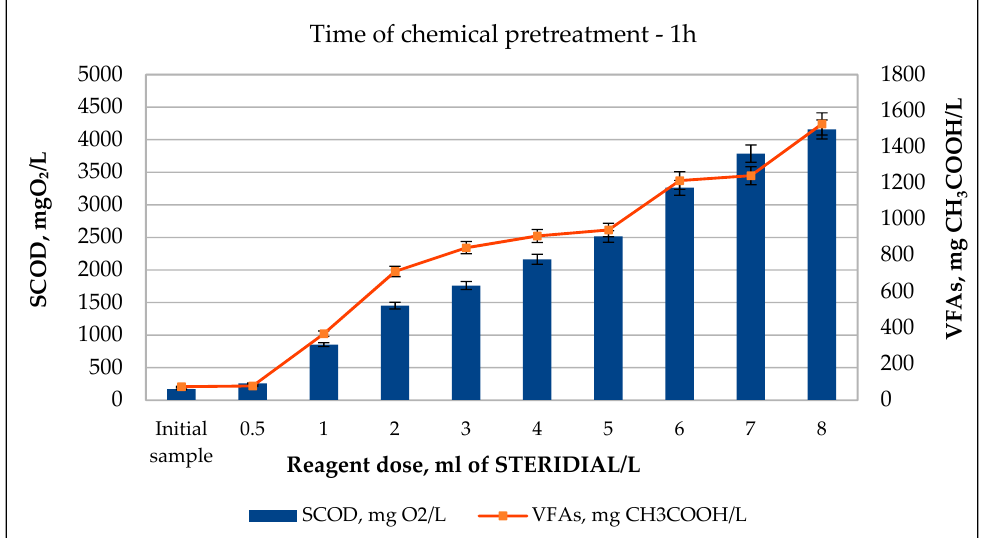
Figure 5. Changes in soluble chemical oxygen demand (SCOD) and concentration of volatile fatty acids (VFAs) determined in the supernatant liquor of chemically disintegrated excess sludge (pre- treatment time: 1 h) recorded in relation to the reagent doses used.